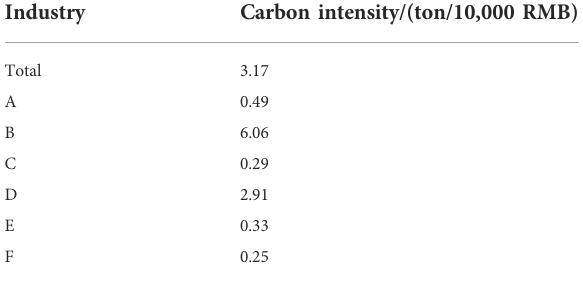
TABLE 3 Carbon intensity of six industries in